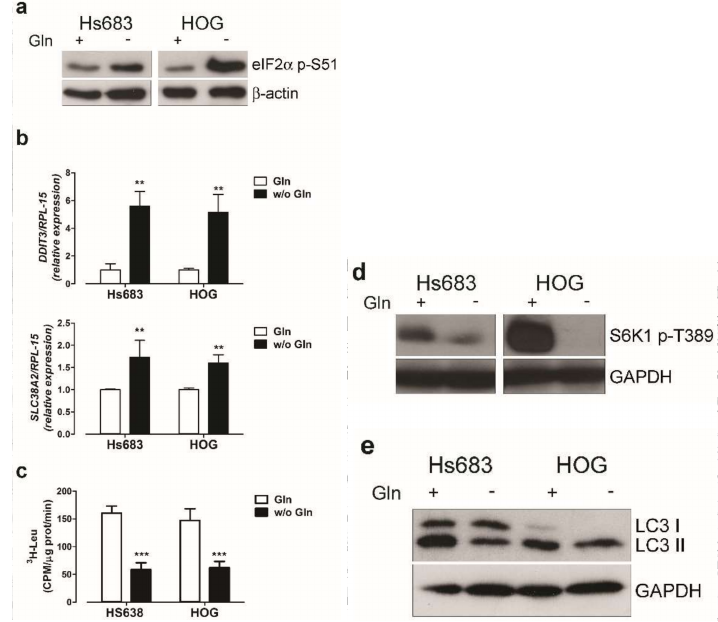
Figure 4. Gln starvation triggers a nutritional stress response. ( a – e ) Hs683 and HOG cells were incubated in the presence (+) or in the absence ( − ) of Gln. ( a ) Western blot of eIF2 α (p-S51) upon